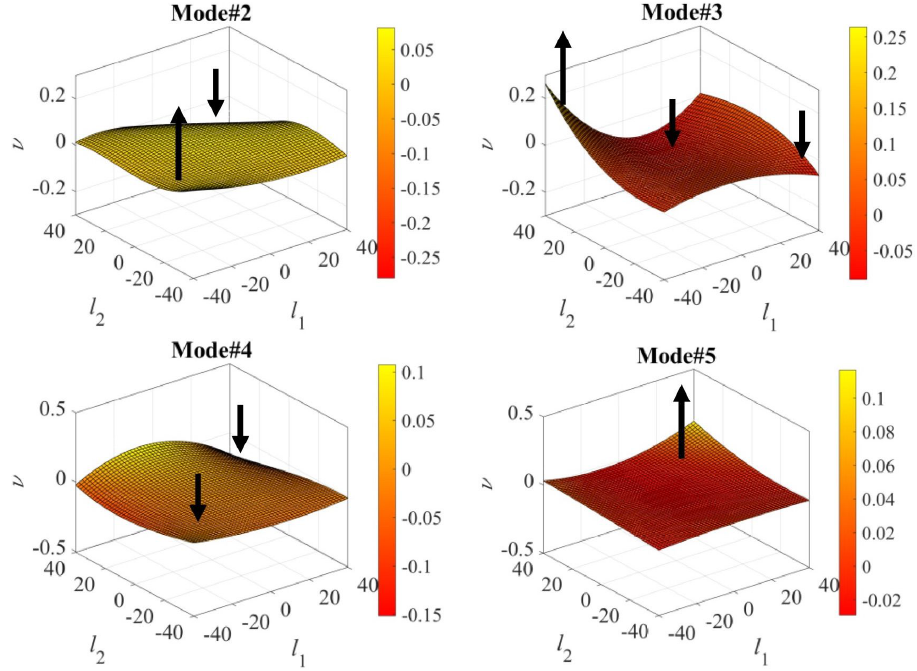
Figure 18: Examples of upper pressure modes for geometry G 1 with θ = 0 ∘ . The black arrows indicate the upward or downward